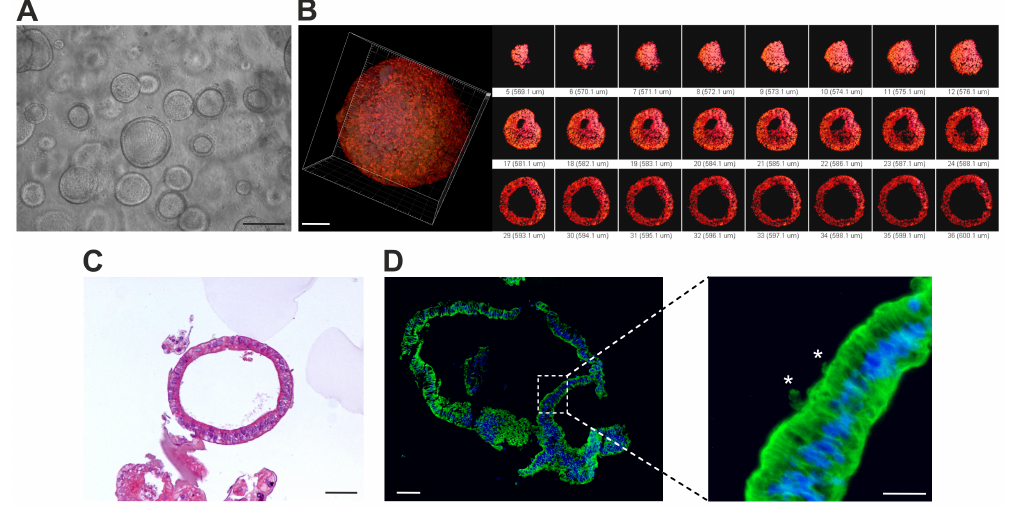
Figure 1. In vitro model of human lung organoids (hLORGs) derived by hiPSCs . ( A ) Phase–contrast microscopy of alveolospheres embedded in 3D Matrigel at day 60 of culture. Scale bar 200 µ m. ( B ) Confo- cal images confirm the spheroidal structure of an hLORG (at day 105) showing a peculiar well-developed inner cavity: in red staining of cytoskeleton by total actin. Scale bar 60 × and 30 µ m, respectively. ( C ) Haematoxylin and eosin-stained hLORG cross-section showing the typical epithelial morphology. Scale bar 50 µ m. ( D ) Immunofluorescence images show the overall α -tubulin distribution (green) of an hLORG displaying a prominent epithelial structure (nuclei, blue). At higher magnification, it is visible in the presence of ciliated cells (*). Scale bar 50 µ m and 25 µ m, respectively.